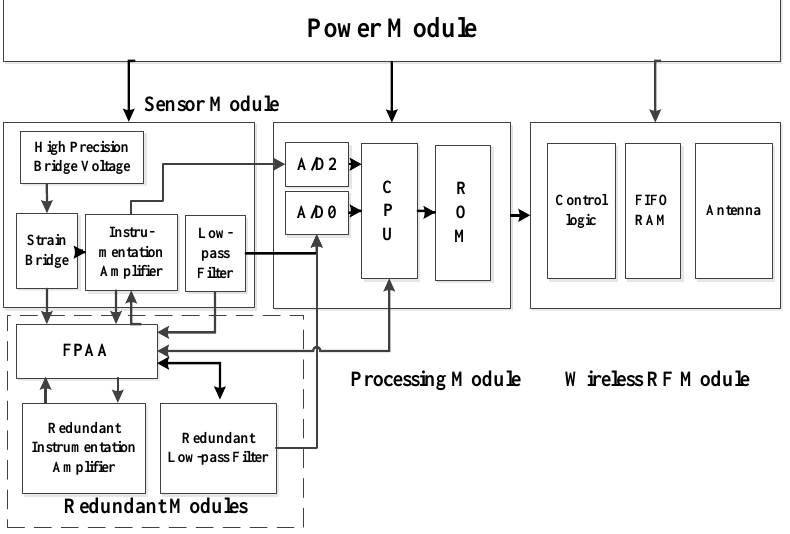
Figure 4. Hardware structure of the redundancy-based self-healing WSN strain